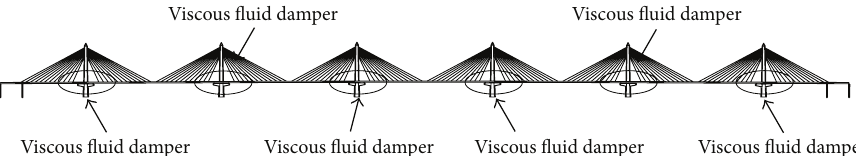
Figure 11: Installation of viscous fluid dampers in the fully floating